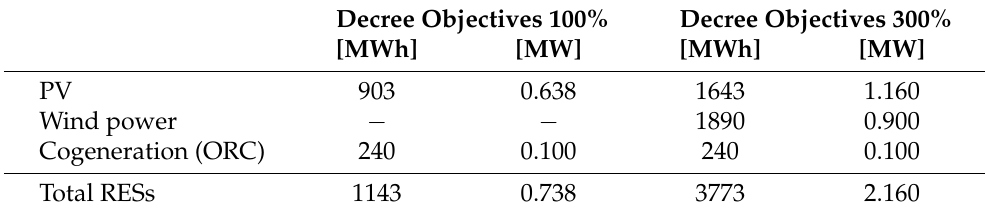
Table 8. Electricity generation scenarios from RESs (energy and